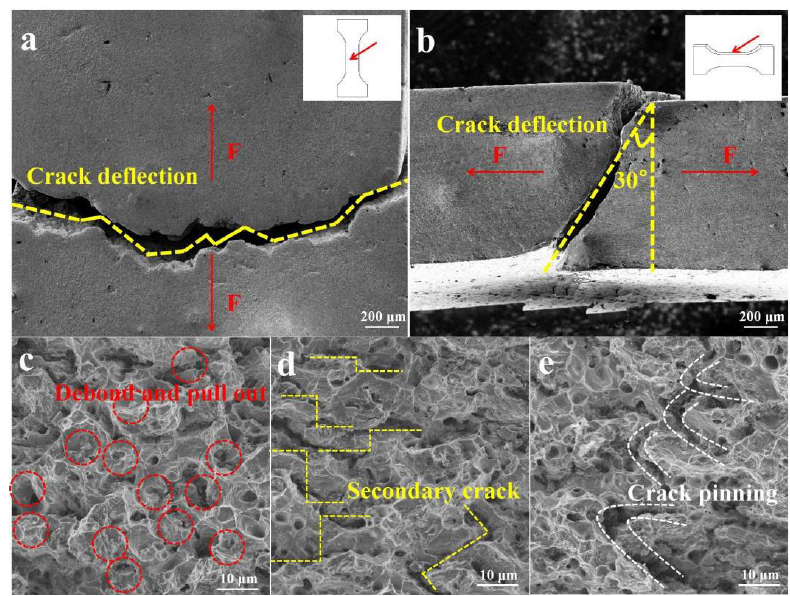
Figure 10. ( a , b ) Orientation relationship of the interface after deformation. ( c ) Comparison of the XRD patterns before deformation and perpendicular to the tensile direction after deformation. ( d ) Normalized curve of the strain-hardening rate vs. true strain. SSCu@rGO also leads to an increase in fracture energy during deformation. The details of these processes are shown in Figure 11: crack deflection [64], rGO debonding and pulling out, the formation of secondary cracks, and crack pinning [65].